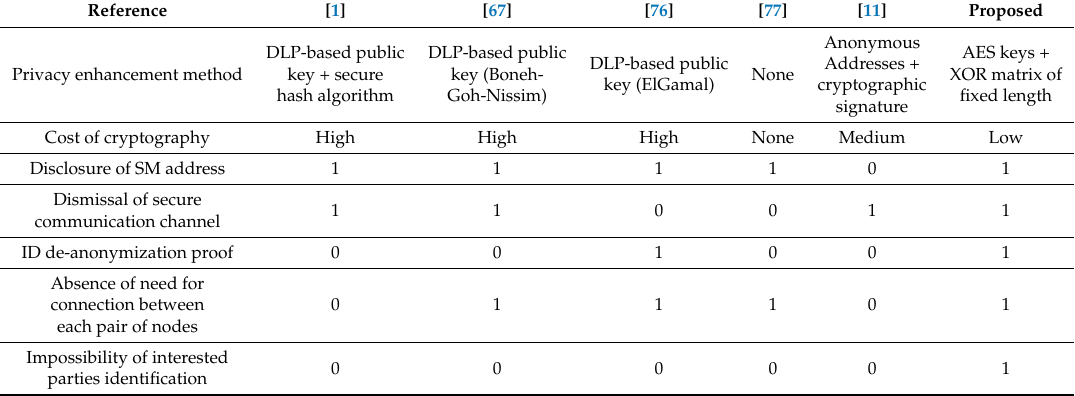
Table 2. Comparison between the proposed framework and the state-of-the-art approaches in terms of